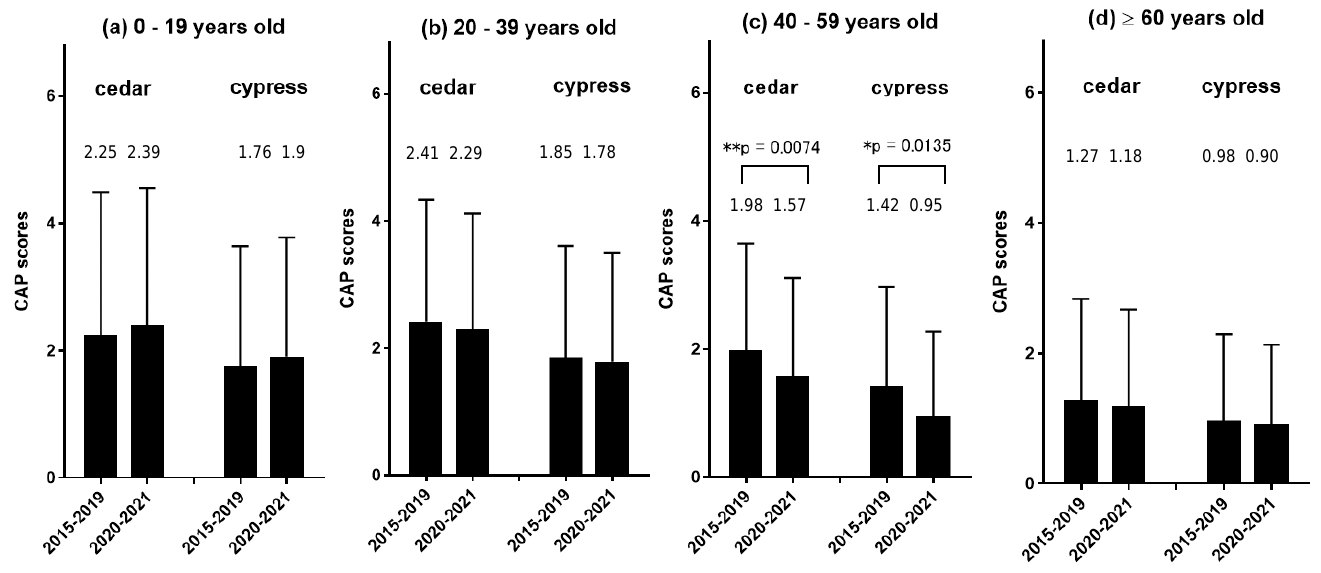
Figure 2. Comparison of CAP scores for cedar and cypress in each age group between the pre- COVID-19 (2015–2019) and COVID-19 (2020–2021) eras. ( a ) 0–19, ( b ) 20–39, ( c ) 40–59, ( d ) ≥ 60 years old groups. The data are mean ± SD (error bars). * p < 0.05, ** p < 0.01.